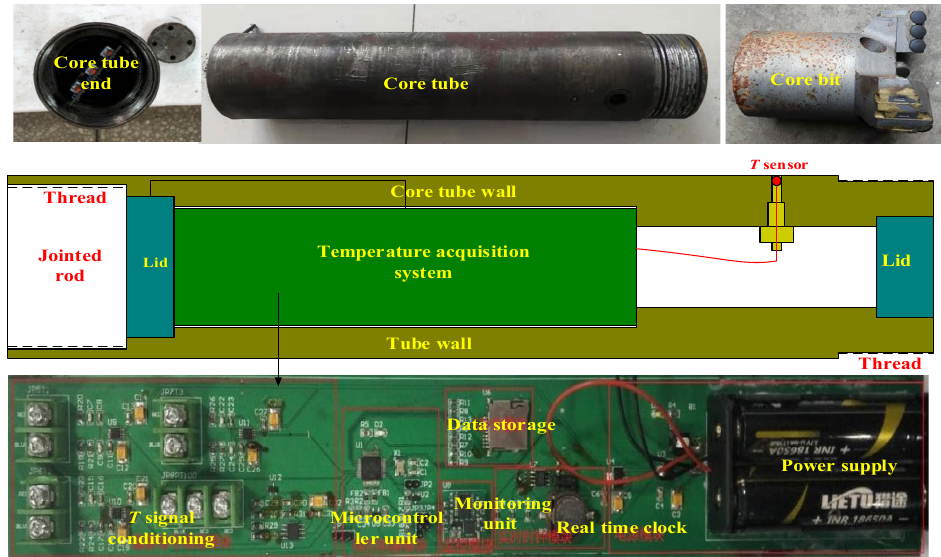
Figure 6. Temperature measuring device for the core tube